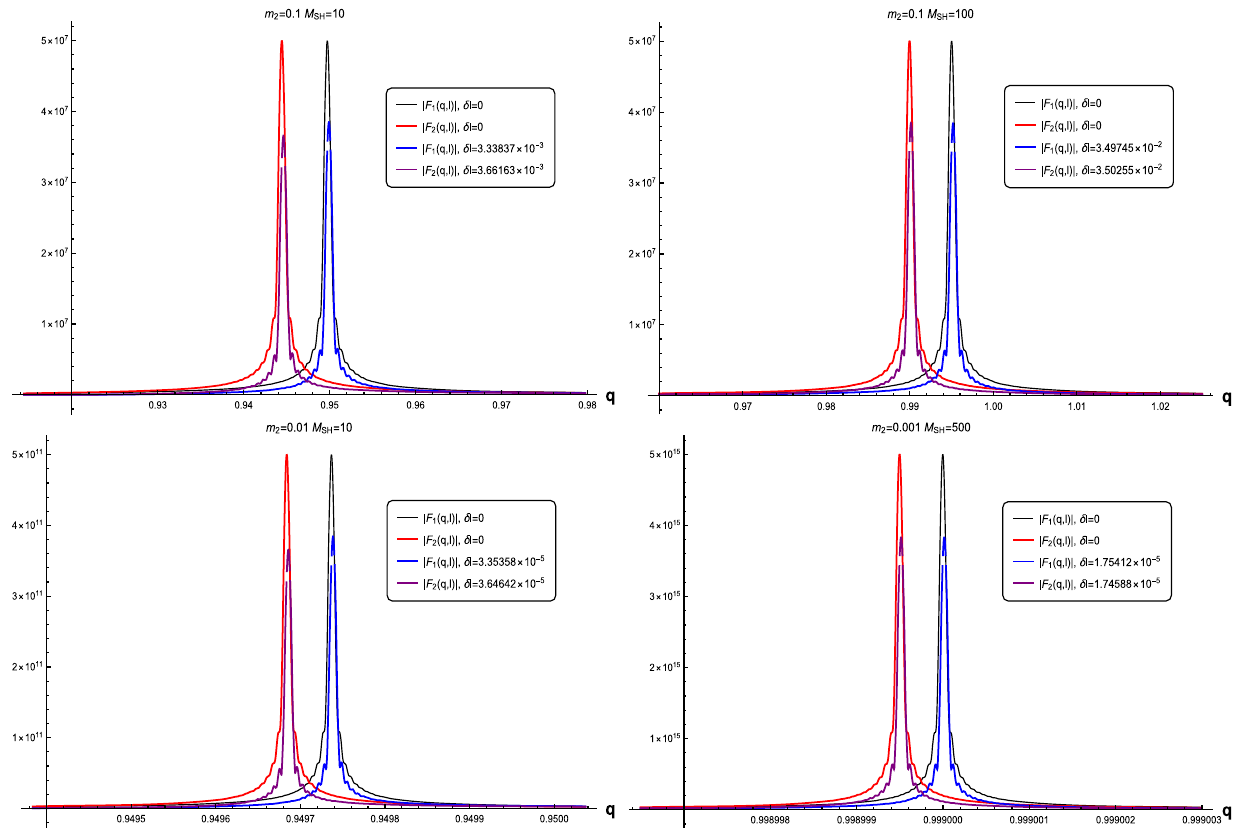
Fig. 2 F ( q , l ) plotted for different values of m 2 and M SH . The same values of l should be used for both mass eigenstates. For this reason we defined δ l = l − ˜ l , where ˜ l = ( l 1 , s + l 2 , s )/